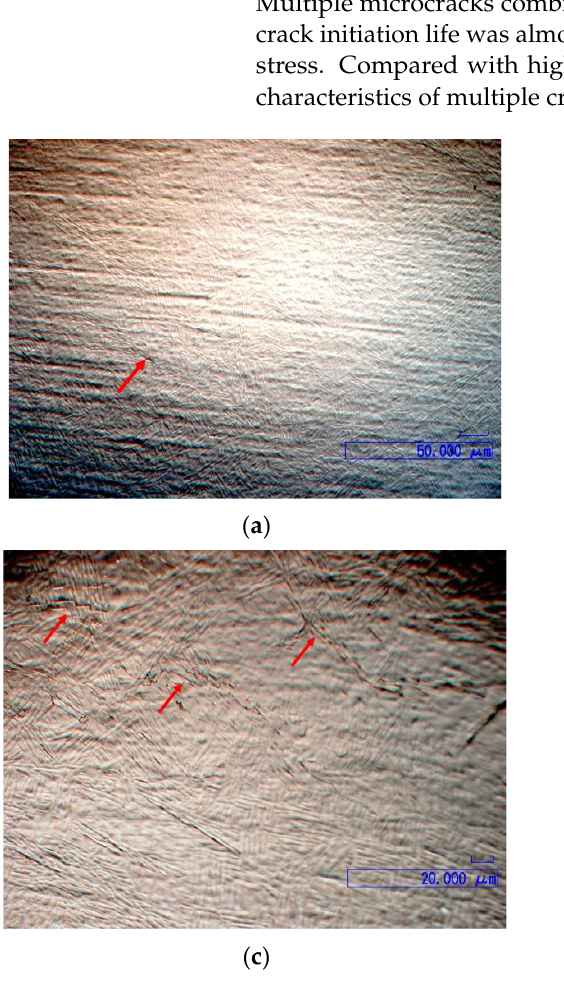
Figure 6. Fatigue crack evolution of TC21 titanium alloy specimen under 1000 MPa stress amplitude (Red arrows represent fatigue cracks; red rings represent fatigue crack coalescence). ( a ) N = 10 cycles (1% Nf ). ( b ) N = 100 cycles (10% Nf). ( c ) N = 300 cycles (30% Nf ). ( d ) N = 450 cycles (46% Nf ).